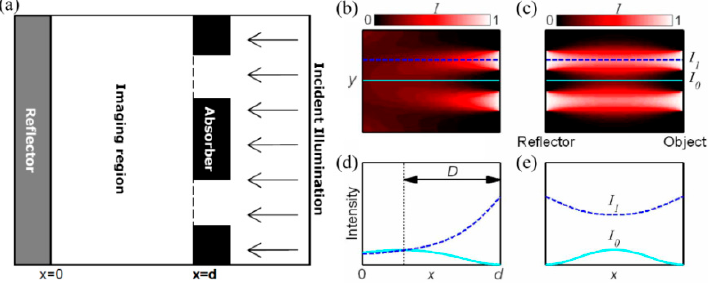
Figure 26. ( a ) Schematic structure of plasmonic reflective lens lithography; Image intensity distribution ( b ) without reflection and ( c ) with reflection. The longitudinal profile distribution of I 0 and I 1 in (b,c) are shown in ( d , e ). Reproduced from: [111], Copyright © 2007, OAS.